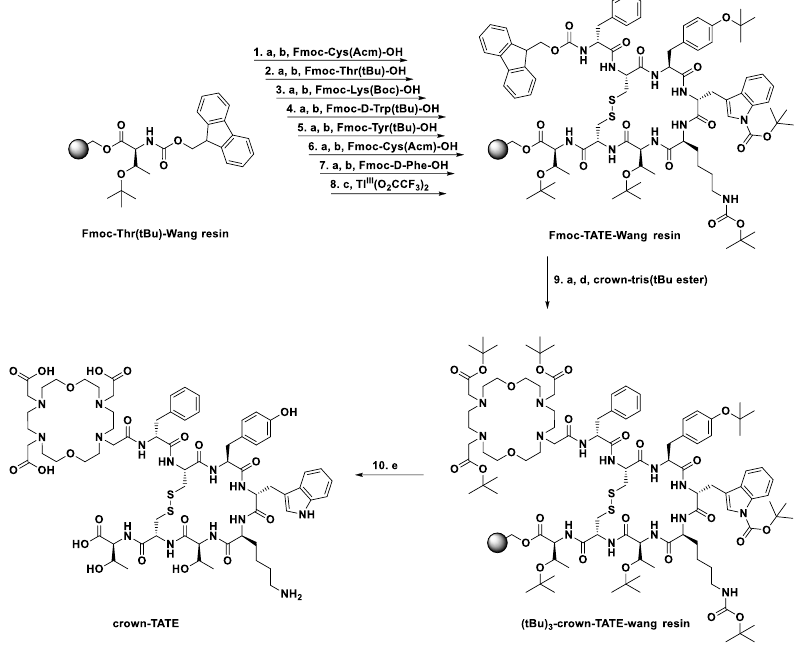
Figure 1. Solid phase peptide synthesis of crown - TATE. ( a ) Fmoc deprotection—20% piperidine in DMF; ( b ) amino acid coupling—PyBop (4 eq.), Oxyma Pure (4 eq.), DIPEA (15 eq.) in DMF, 2 h; ( c ) cyclisation—Tl(III)(O 2 CCF 3 ) 2 in DMF/anisole (19:1), 3 h; ( d ) chelator coupling—PyBop (4 eq.), Oxyma Pure (4 eq.), DIPEA (15 eq.) in DMF, 21 h; ( e ) deprotection and resin cleav- age—TFA/TIPS/H 2 O/Thioanisole/Phenol (82.5:2.5:5:5:5), 3 h.